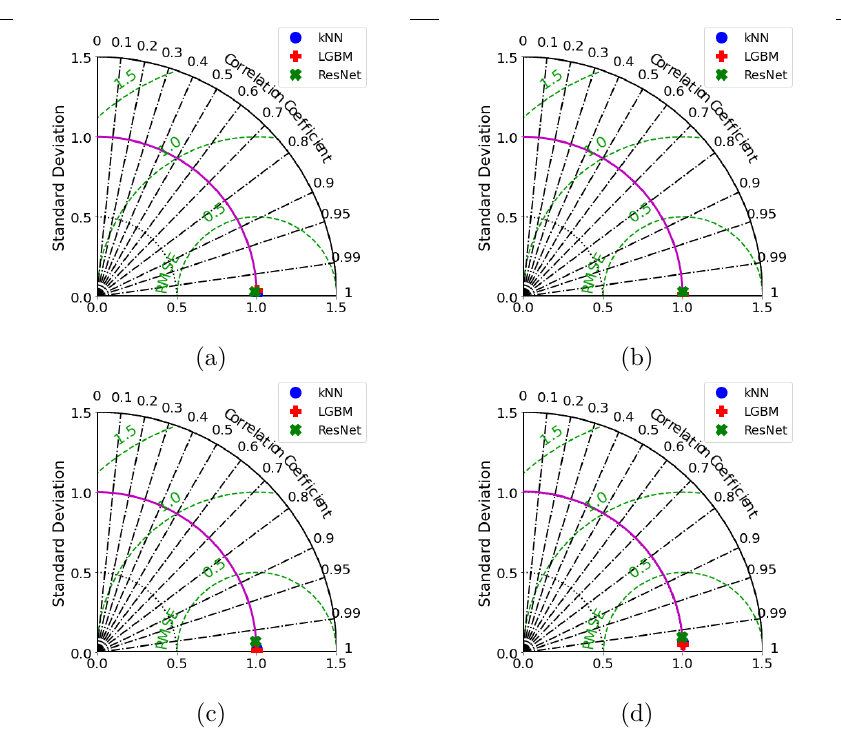
Figure 7. Taylor diagrams for: (a) stress component σ component σ in CF 1, and (d) stiffness component K x